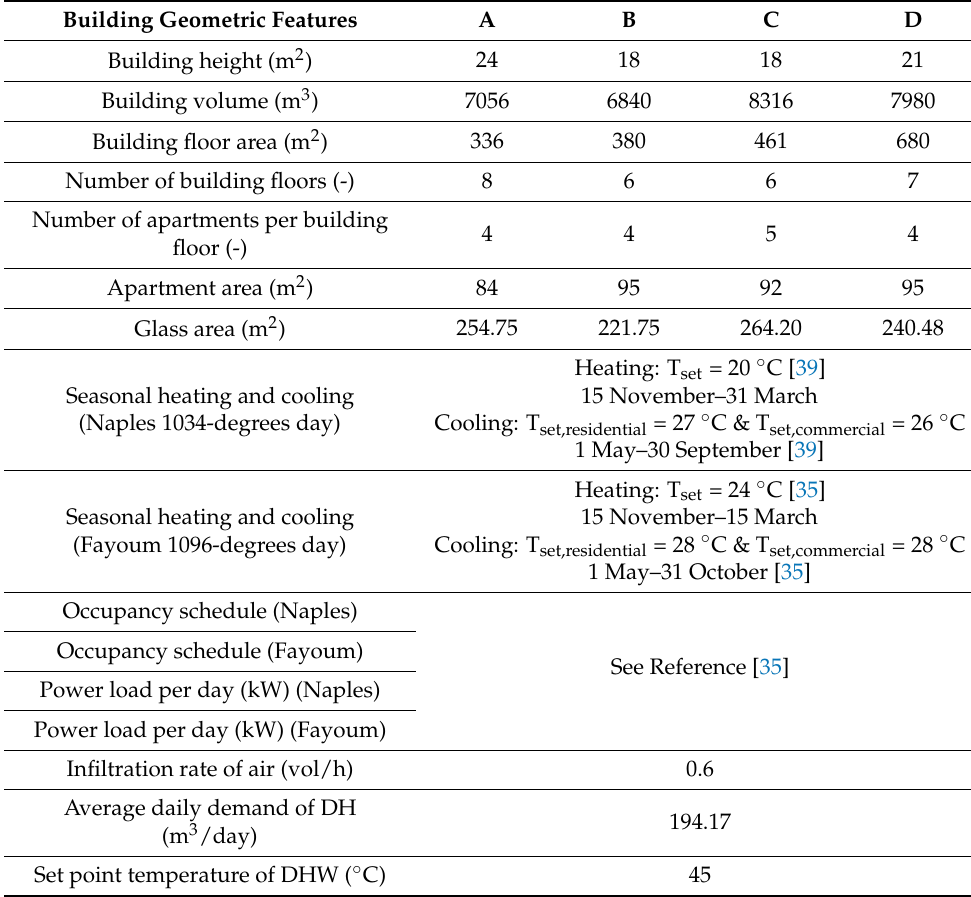
Table 6. Building simulation input